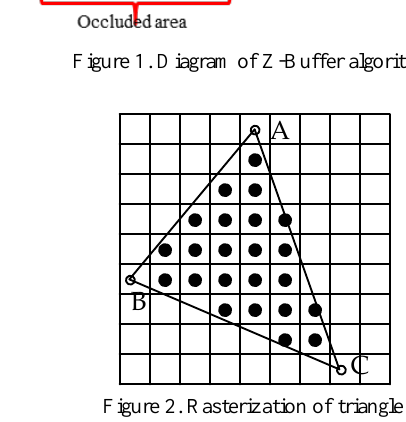
Figure 1. Diagram of Z-Buffer algorithm